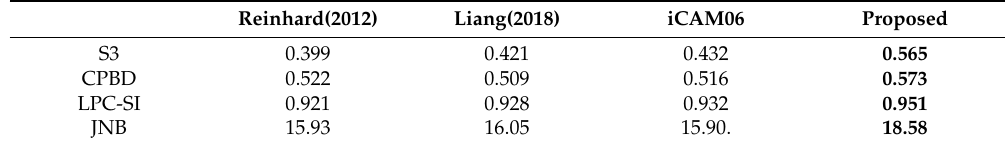
Figure 11. HDR rendered images (wood). ( a ) Reinhard (2012), ( b ) Liang (2018), ( c ) iCAM06 and ( d ) proposed method. Table 1. Comparison with sharpness scores.